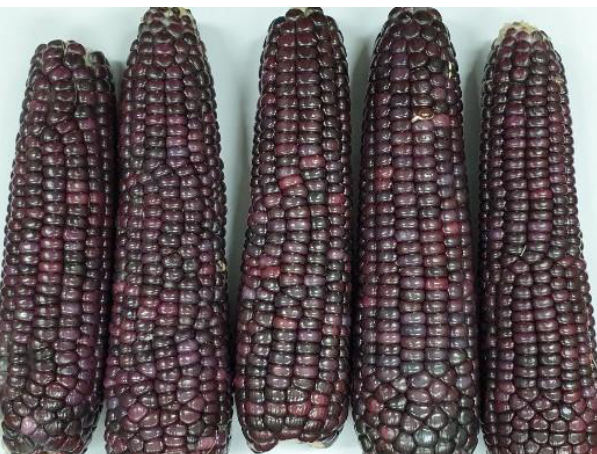
Figure 1. Kernels of purple corn. Sci. Pharm. 2023 , 91 , x FOR PEER REVIEW